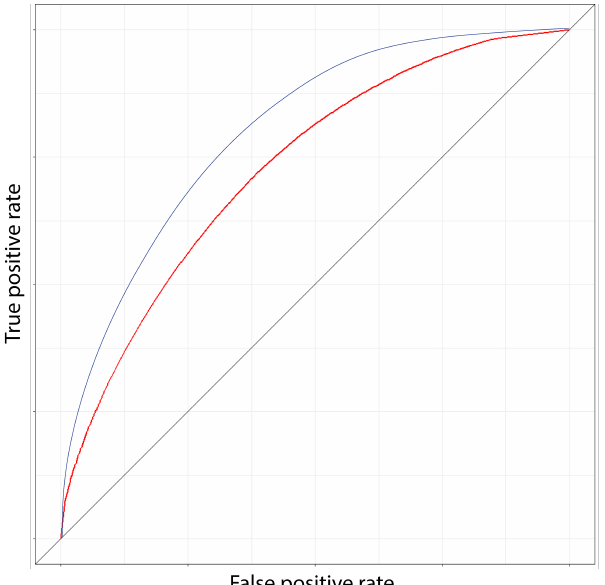
Figure 14. ROC curves for Santa Cruz (in red, AUC = 0.73) and for San Ignacio de Velasco (in blue, AUC = 0.8).